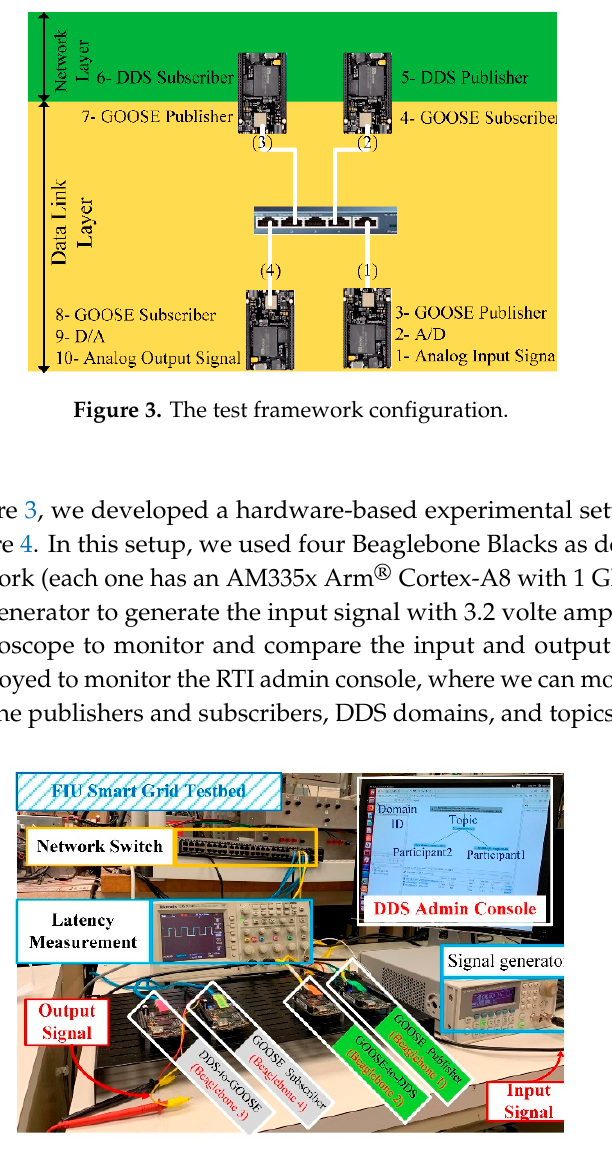
Figure 4. Experimental setup at the Florida International University (FIU) smart grid testbed.